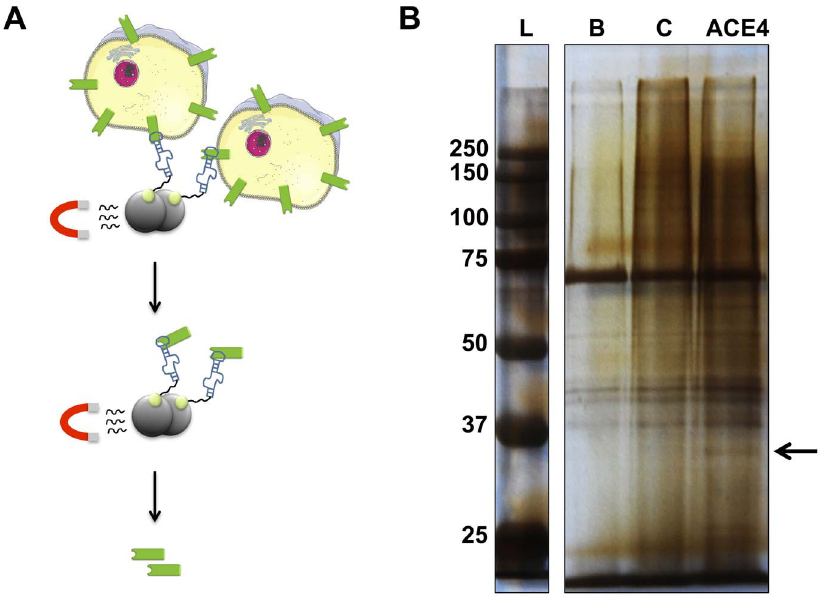
Figure 2. ACE4 aptamer-mediated target purification. A) Schematic representation of the method. Biotinylated aptamers (blue) bound to cells are attached to magnetic streptavidin beads and concentrated by magnetic field. Then, cells are lysed on beads and magnetic field is used to purify the target (green) bound to the aptamers before elution. B) After elution, the extracted proteins were separated by SDS-PAGE electrophoresis before being silver-stained in a polyacrylamide gel. Lane L, molecular marker. Lane B, extracted proteins with empty beads. Lane C, extracted proteins with a biotinylated scramble sequence. Lane ACE4, extracted proteins with the biotinylated ACE4 aptamer. The Arrow indicates a band with a substantial higher intensity in lane ACE4 compared to lane B and C. This band has been cut and analyzed by nano-LC-MS/MS Mass-spectrometry.